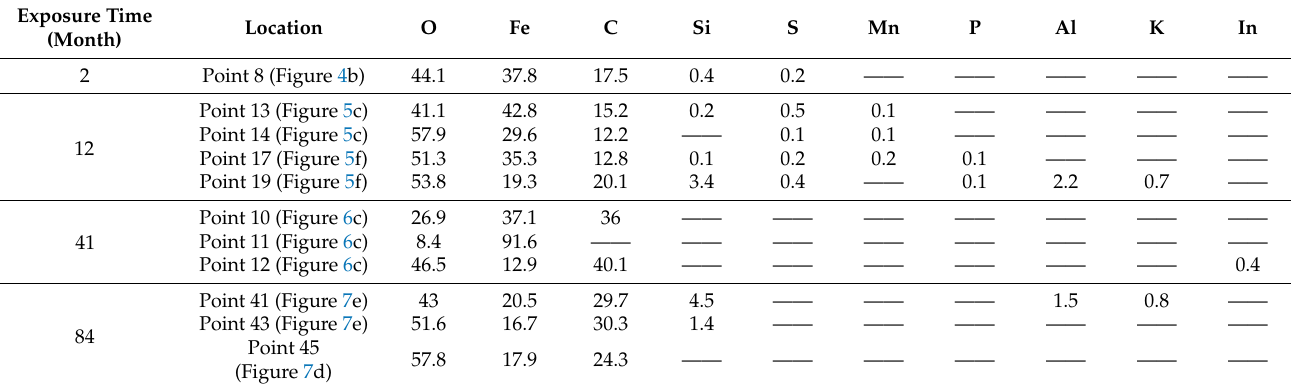
Table 4. The element concentrations in corrosion products at different atmospheric exposure times (at.